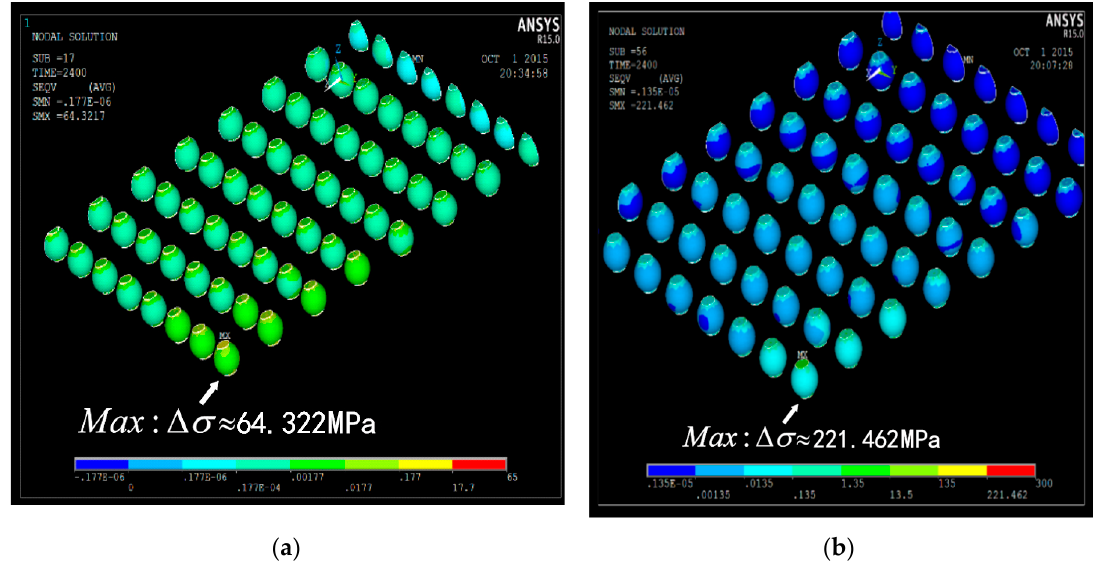
 load profile; ( b ) In  load profile. Figure 8. Distribution of stress and strain contours: ( a ) In Figure 8. Distribution of stress and strain contours: ( a ) In Ω 1 load profile; ( b ) In Ω 2 load profile. 1 2 Table 3. Simulation results under thermal load profiles. Table 3. Simulation results under thermal load